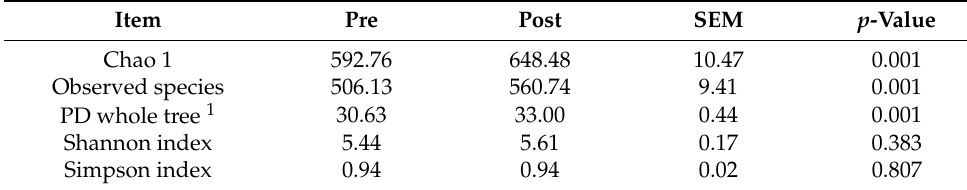
Table 4. Rumen bacterial alpha diversity metrics before (Pre) and after (Post) diet shift. Item Pre Post SEM p -Value Chao